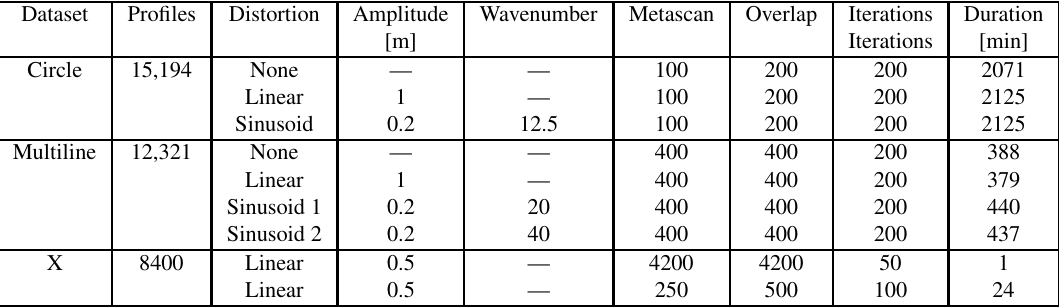
Table 1. Parameters for applied distortions and continuous-time